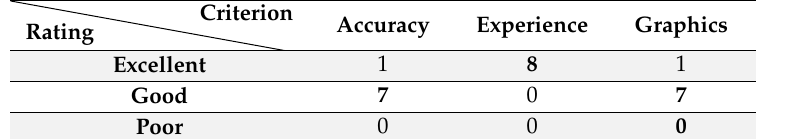
Table 3. Summarized number of users’ rating on Stingray (VR) (Unit: person / people).